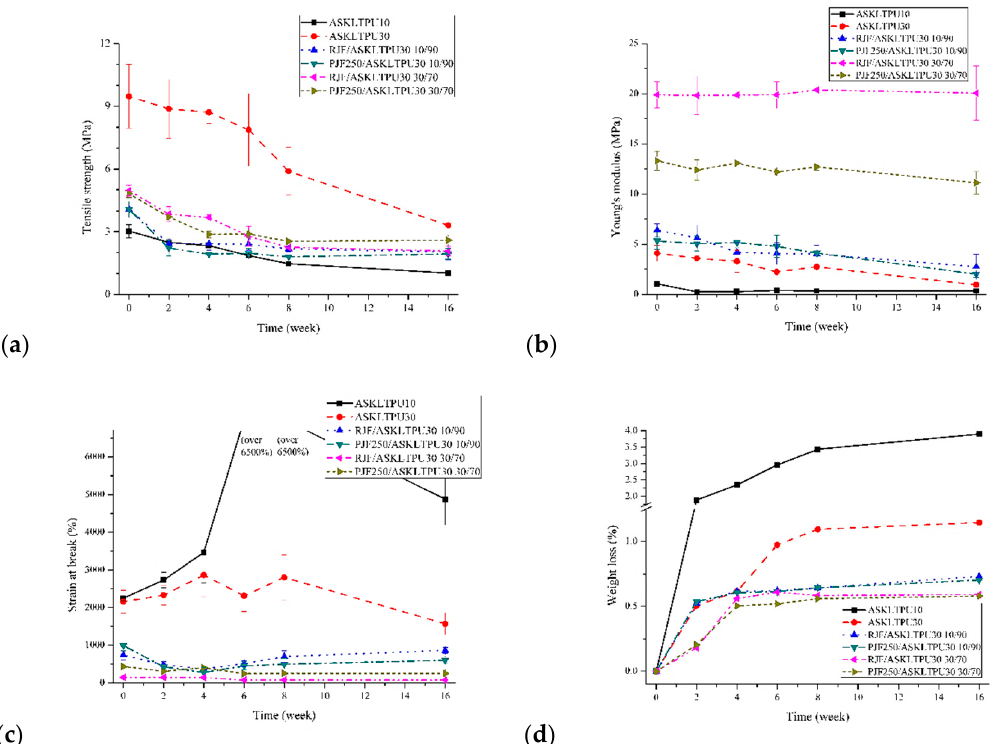
Figure 10. The weight loss and change in mechanical properties of ASKLTPU and JF-reinforced ASKLTPU during the fungal degradation test: ( a ) weight loss; ( b ) tensile strength; ( c ) Young’s modulus; and ( d ) strain at break.